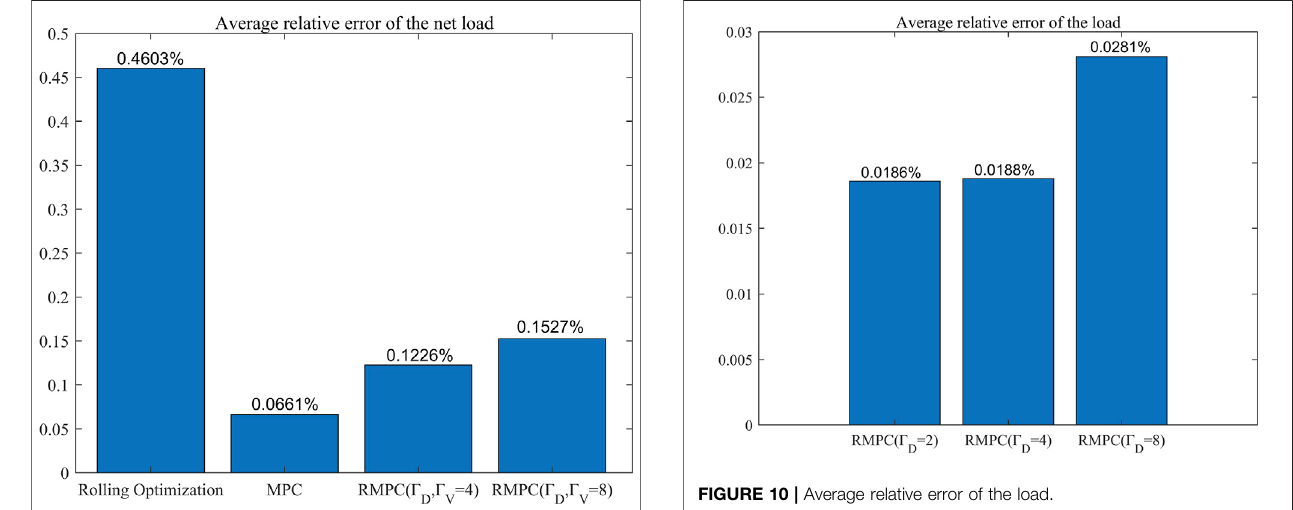
Figure 9 that the error calculation result based on the MPC